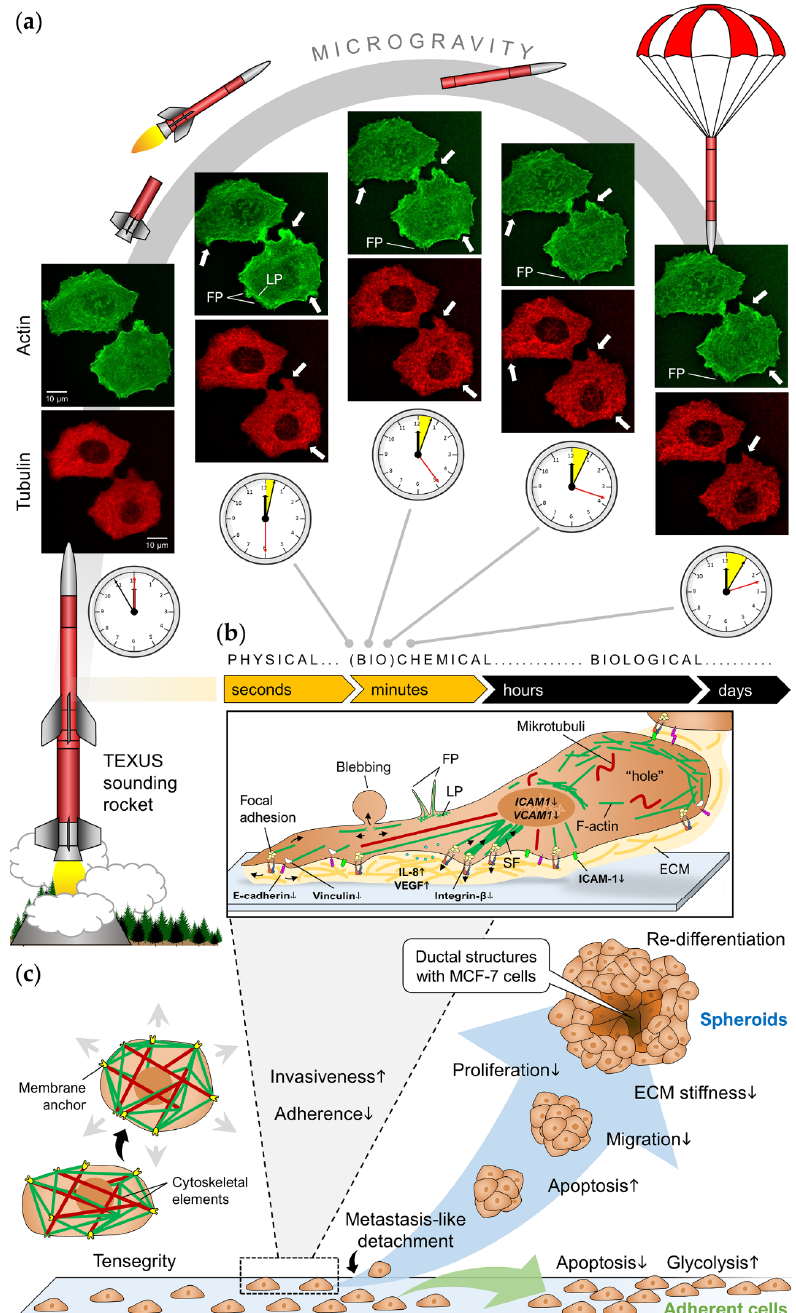
Figure 2. ( a ) Time course images of MCF-7 cells taken on board of the TEXUS-54 sounding rocket during microgravity in comparison to a control image taken 5 min prior to launch. The arrows indicate changes in F-actin (green channel) or α -tubulin (red channel). F-actin cytoskeleton shows appearance of filopodia- and lamellipodia-like structures, accumulation of F-actin, while α -tubulin shows a loose structure and rearrangement of the cytoskeleton. ( b ) Subsequent cellular alterations of adherently growing breast cancer cells after exposure to r- µ g (modified from [54]). F-actin is shown as green lines, the extracellular matrix (ECM) in yellow. The e ff ects observed on parabolic and sounding rocket flights were observed in a time-range from a few seconds until minutes. ( c ) Downstream key processes in both cell populations of human breast cancer cells during long-term exposure to s- µ g . FP, filopodia; LP, lamellipodia; SF, stress